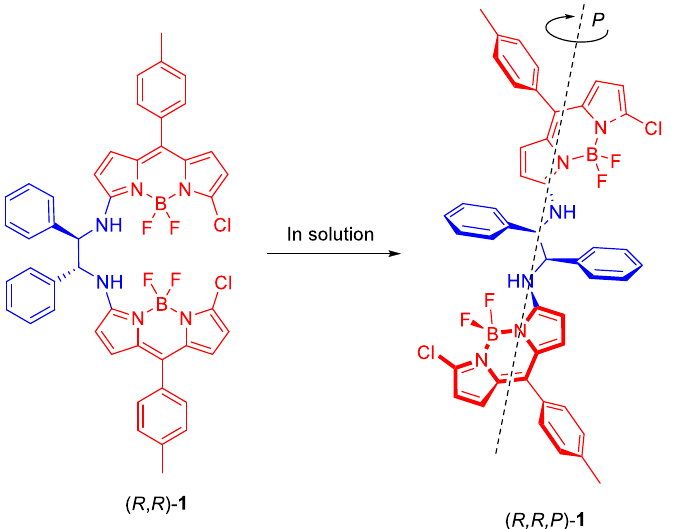
Figure 1. Example of the helicoBODIPY design introduced by de la Moya and its helical conformation with a preferred configuration in solution.